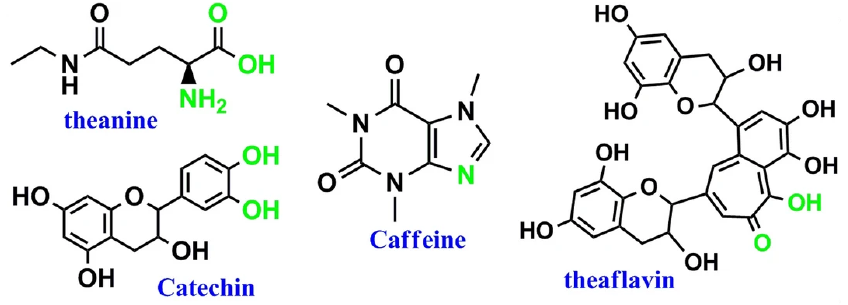
Figure 1. Four major biomolecules of black tea extract [21].